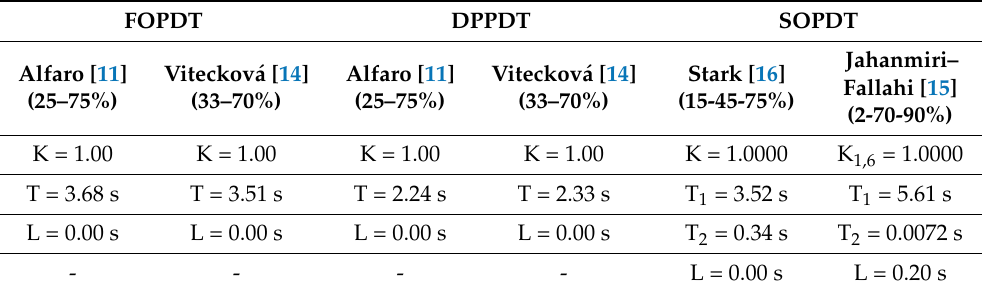
Table 12. FOPDT, DPPDT, and SOPDT model settings obtained for the considered integer-order identification methods.